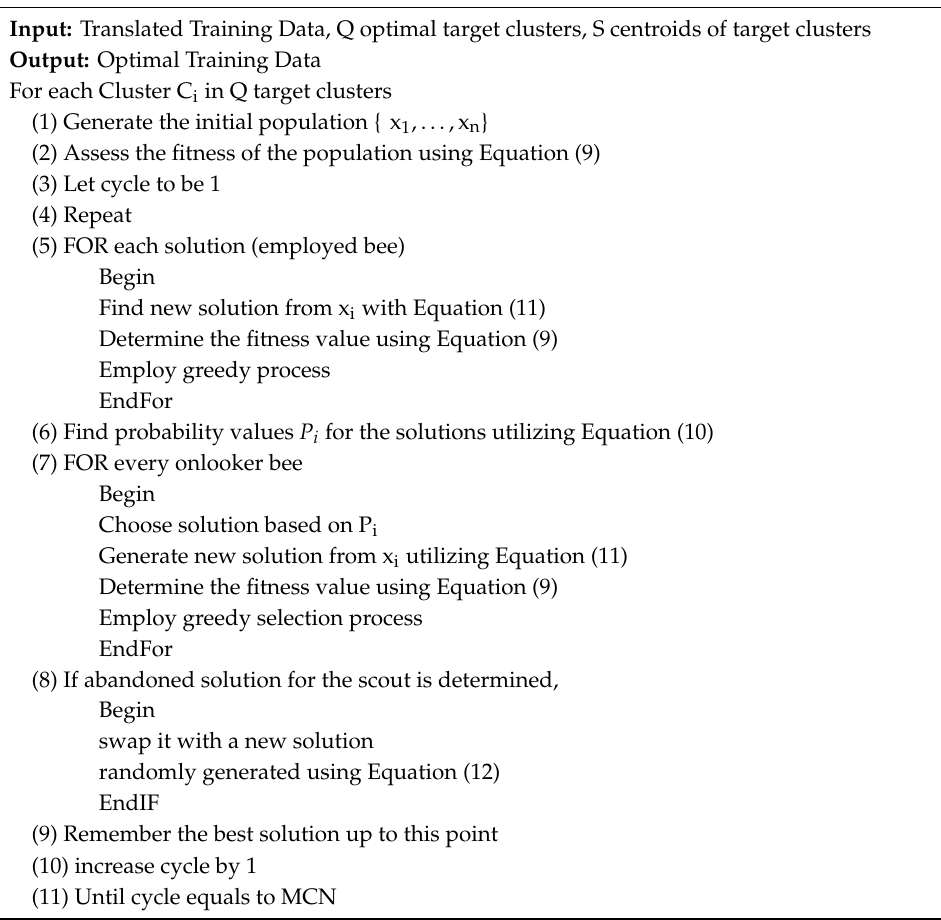
Algorithm 1. ABC algorithm Pseudo